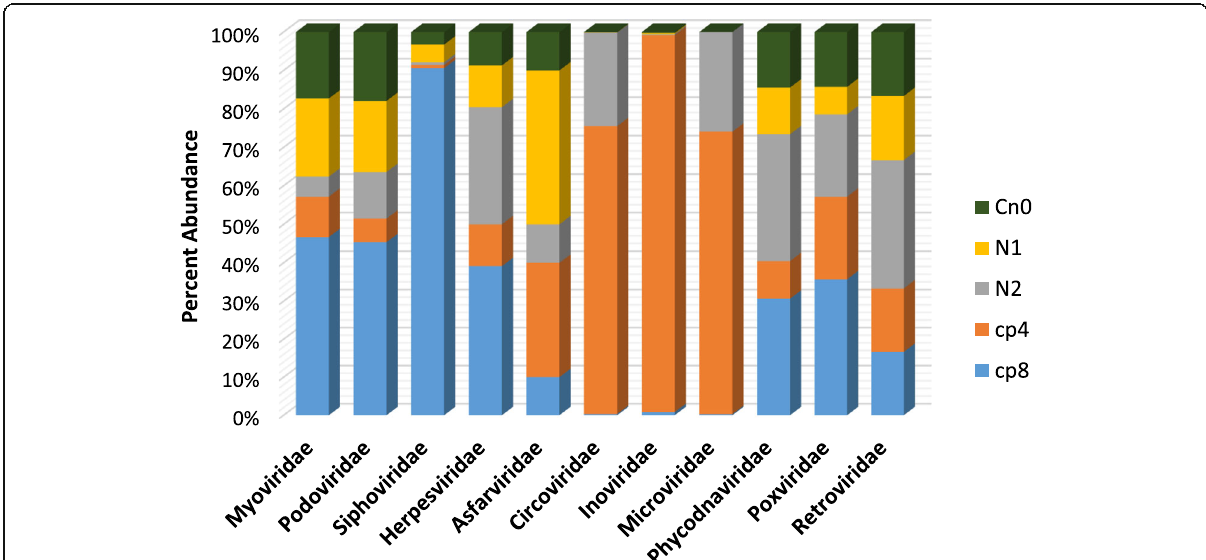
Fig. 4 Percent abundance of major viral families present in the maize rhizosphere under the fertilization treatments, Cn0 (control), N1 (60 kg/ha NPK), N2 (120 kg/ha NPK), Cp8 (8 tons/ha compost), and Cp4 (4 tons/ha compost